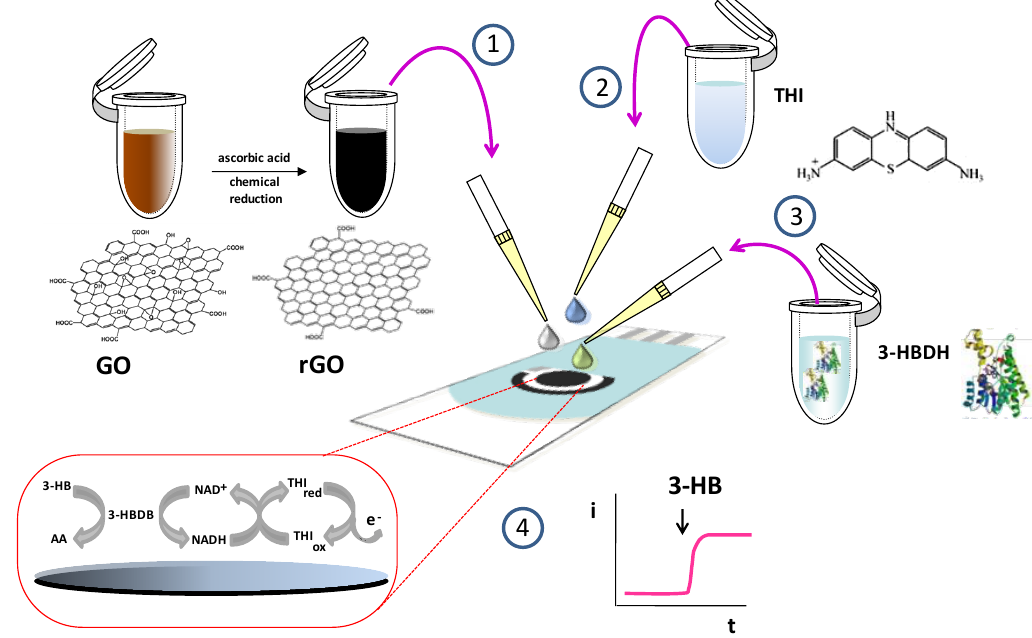
Figure 1. Scheme of the steps involved in the preparation and functioning of the 3-hydroxybutyrate dehydrogenase (3-HBDH)/thionine (THI)/reduced graphene oxide (rGO)/screen-printed carbon electrode (SPCE) biosensor.